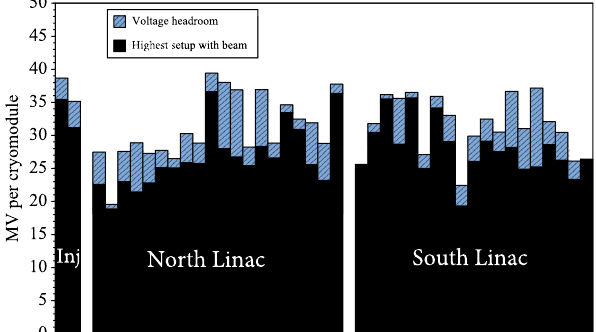
FIG. 11. CEBAF available SRF cryomodule voltage in 1996 (from [63]).